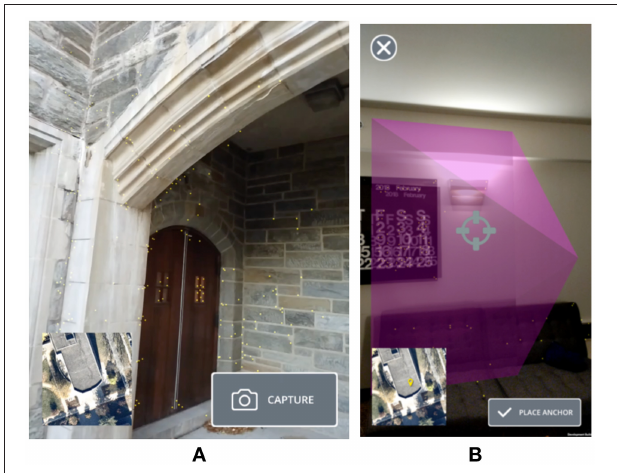
FIGURE 5 | (A) Image showing the initial capture interface; the yellow dots are the point cloud. (B) Image showing the application reanchoring an image. The pink pyramid represents the relationship between the camera position and image plane in terms of position and